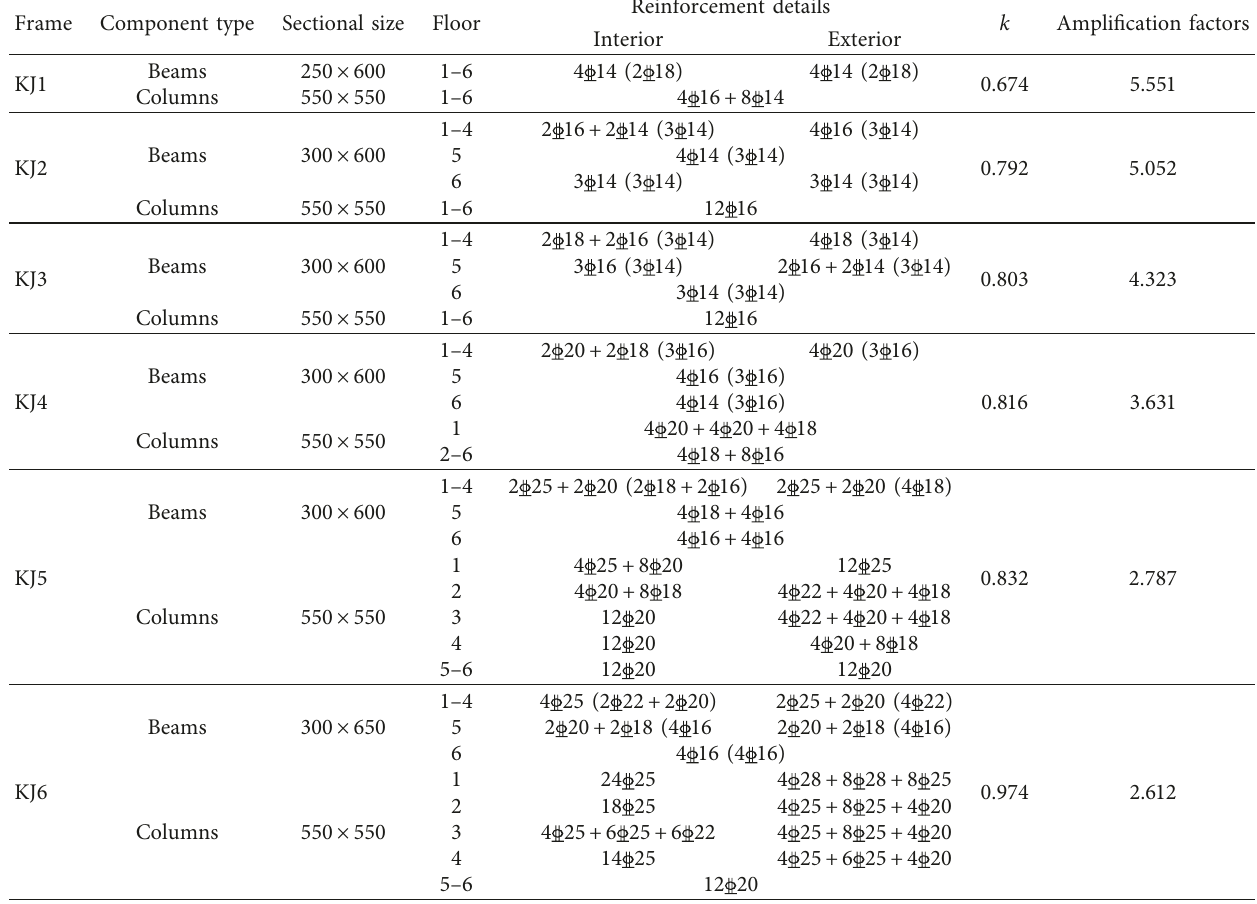
Table 5: Design parameters of numerical models (not considering the limit values in Table 2).